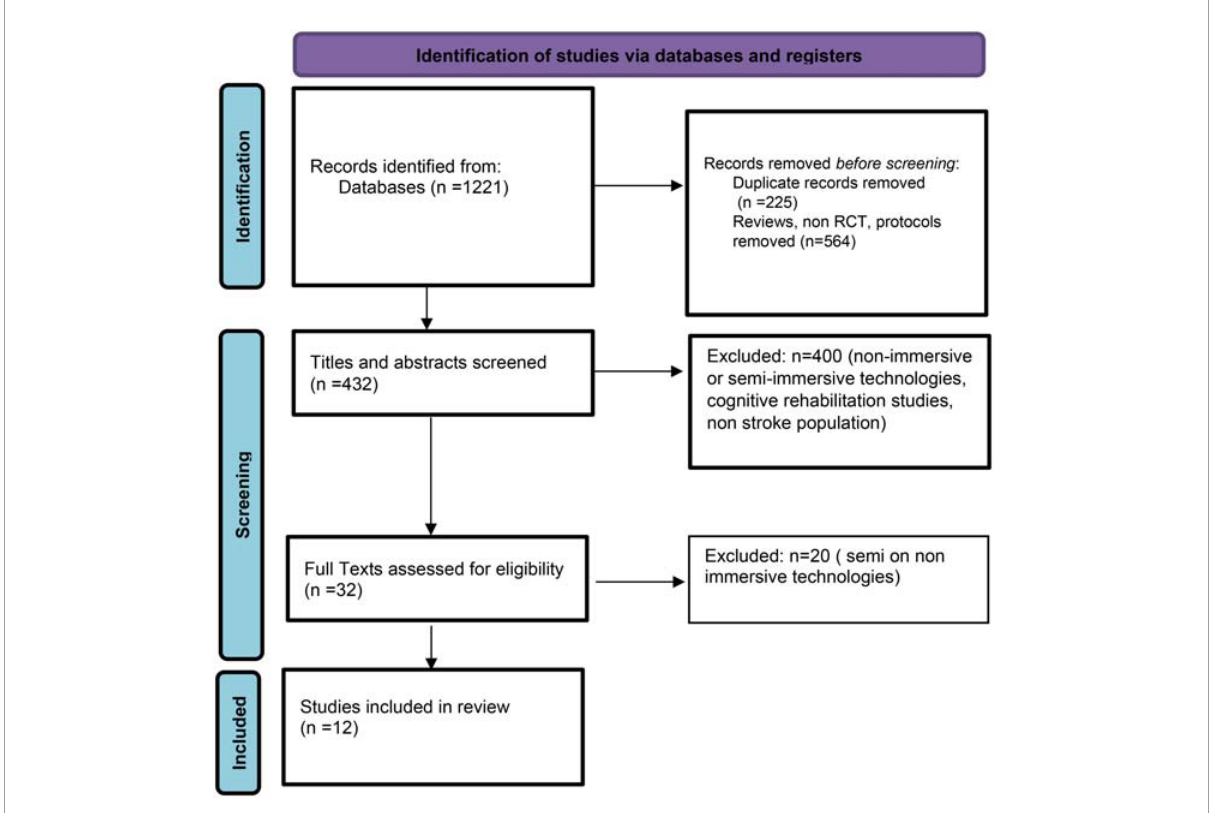
FIGURE1 Flow diagram of selected studies being included in the systematic